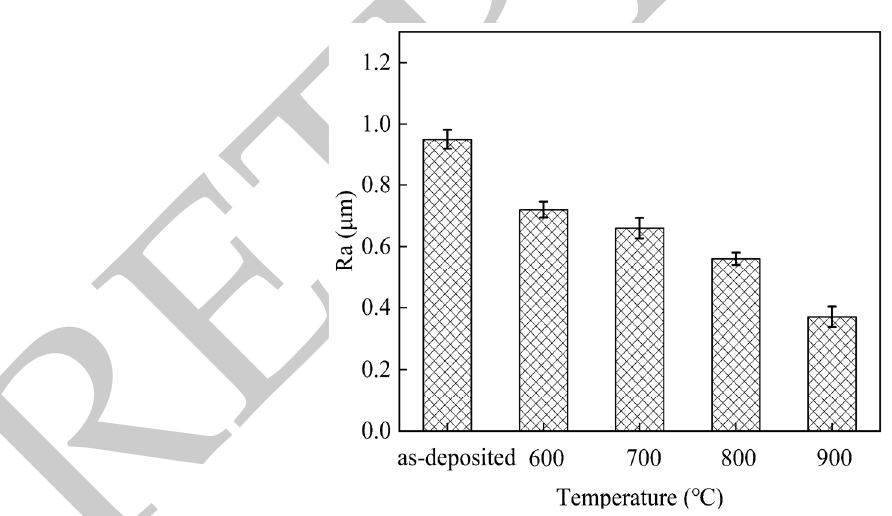
Figure 5. Cross-section morphologies of the AlCrTiSiN coatings before and after annealing, ( a ) as- deposited, ( b ) annealed at 800 °C . 3.3. Mechanical Properties Figure 6 shows the nanohardness of the AlCrTiSiN as-deposited coating and an- nealed coating at different temperatures. It can be seen from the figure that the coating hardness firstly increased gradually with the increase in annealing temperature. When the